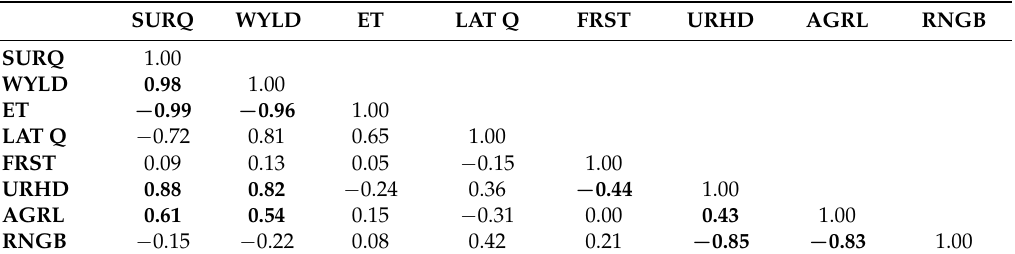
Table 9. Bivariate Pearson correlation for changes in four LULC types and four hydrological components between 2000 and 2013 a . Bold numbers are for p <